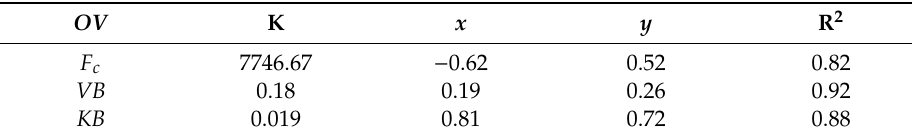
Table 4. Model coe ffi cients.